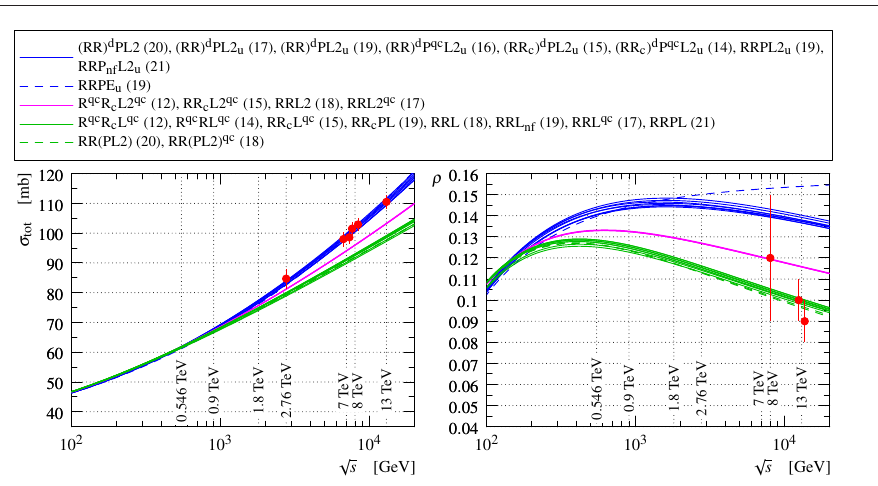
Figure 2. COMPETE bands for the total cross-section σ tot ( s ) and the ρ ( s ) indicate [16] that without an Odderon contribution, recent TOTEM data at √ s = 13 TeV for the pair of ( σ tot ,ρ ) cannot be described simultaneously.